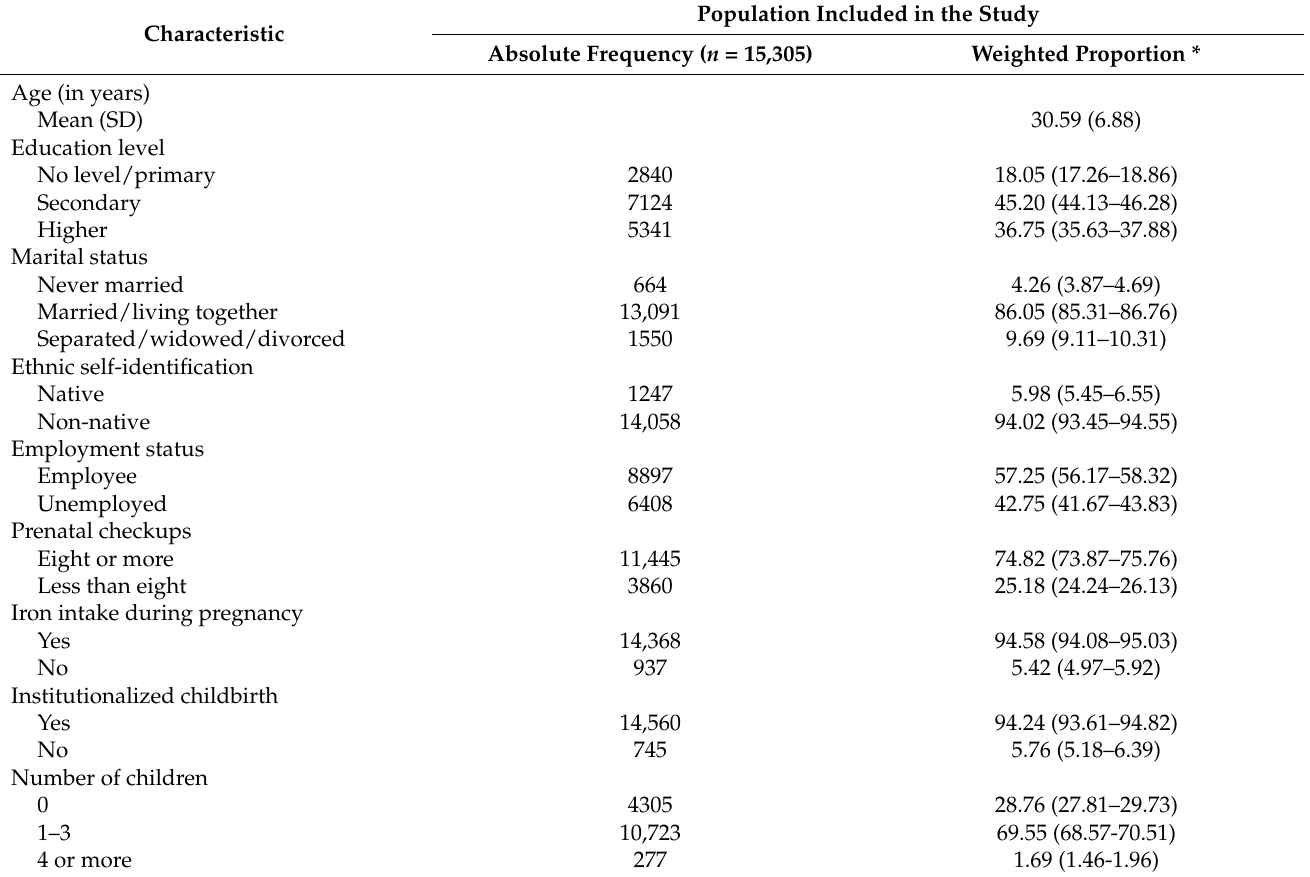
Table 1. Characteristics of the population of women aged 15 to 49 registered in the ENDES